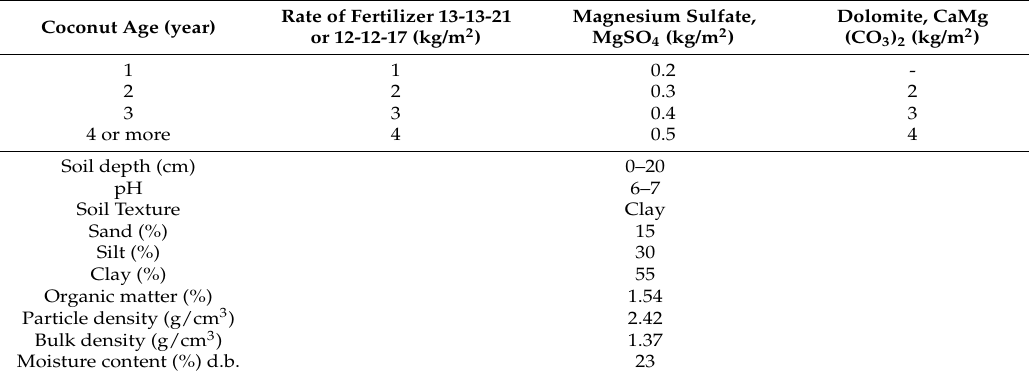
Table 1. Physical properties of soil and fertilizer application* in the coconut